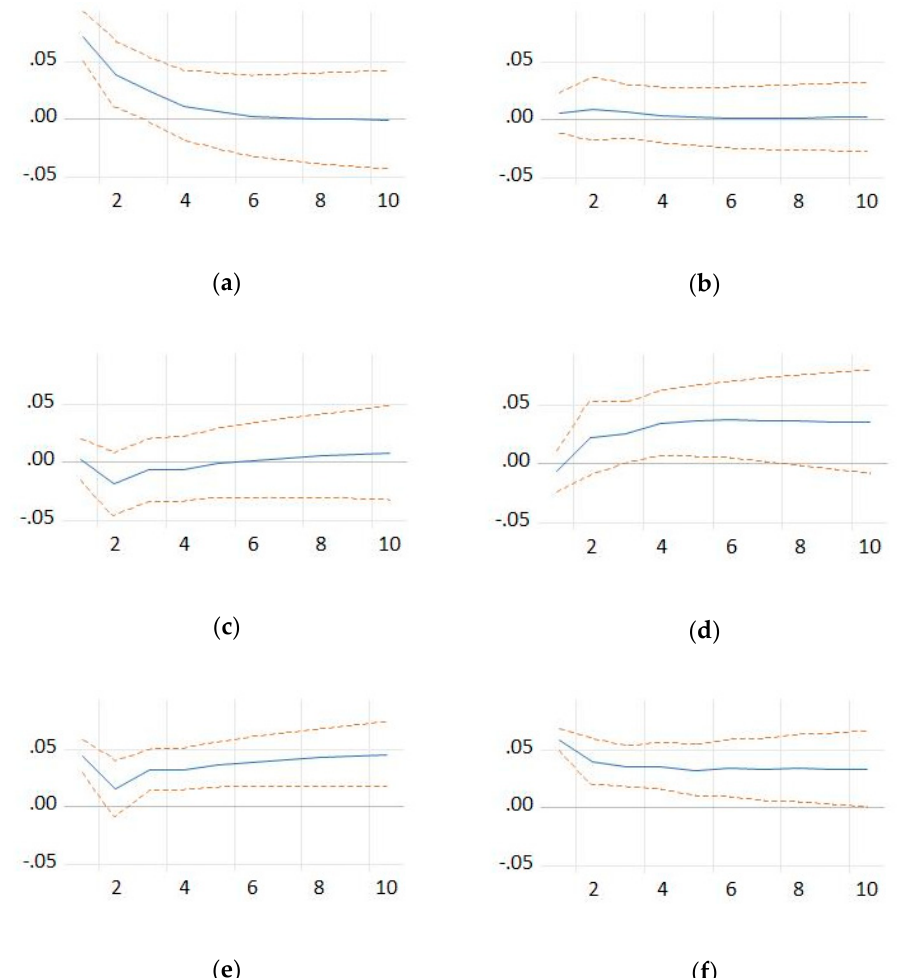
Figure 10. Response of persons employed in the population of births to a shock from: ( a ) births of enterprises; ( b ) GDP per capita; ( c ) nominal labor productivity per person; ( d ) persons employed in the population of deaths; ( e ) persons employed in the population of active enterprises; and ( f ) persons employed in the population of births. Source: the authors’ own computations.